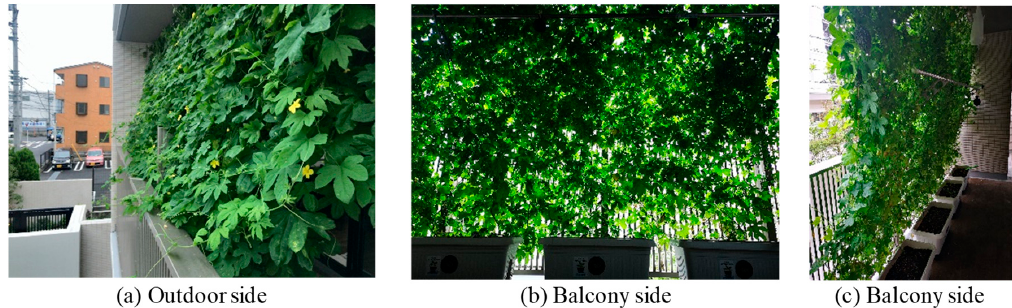
Figure 1. View of a green curtain grown by occupants in the investigated condominium. Table 1. Thermal mitigation effects of the green curtains in previous studies.